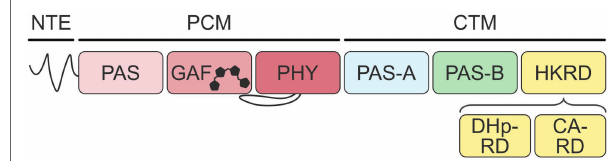
FIGURE 1 | Architecture of plant phytochromes. Phytochromes from land plants possess a photosensory core module (PCM) and a C-terminal module (CTM). The PCM consists of an N-terminal extension, a PAS domain, a bilin- binding GAF domain, and a PHY domain. The CTM contains additional PAS-A, PAS-B, and histidine-kinase-related domains (HKRD). The HKRD in turn comprises DHp-RD and CA-RD